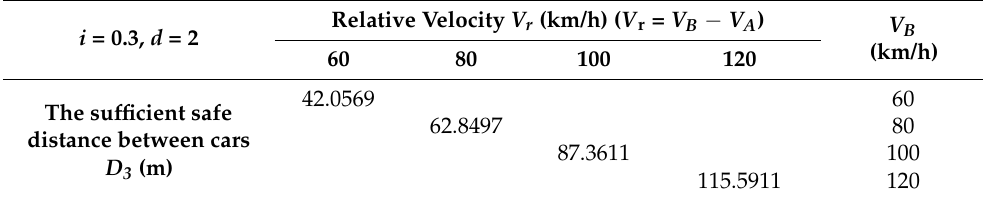
Table 7. The sufficient safe distance D 3 based on V B between 60 and 120 km/h when i = 0.3 and d = 2. i = 0.3, d =